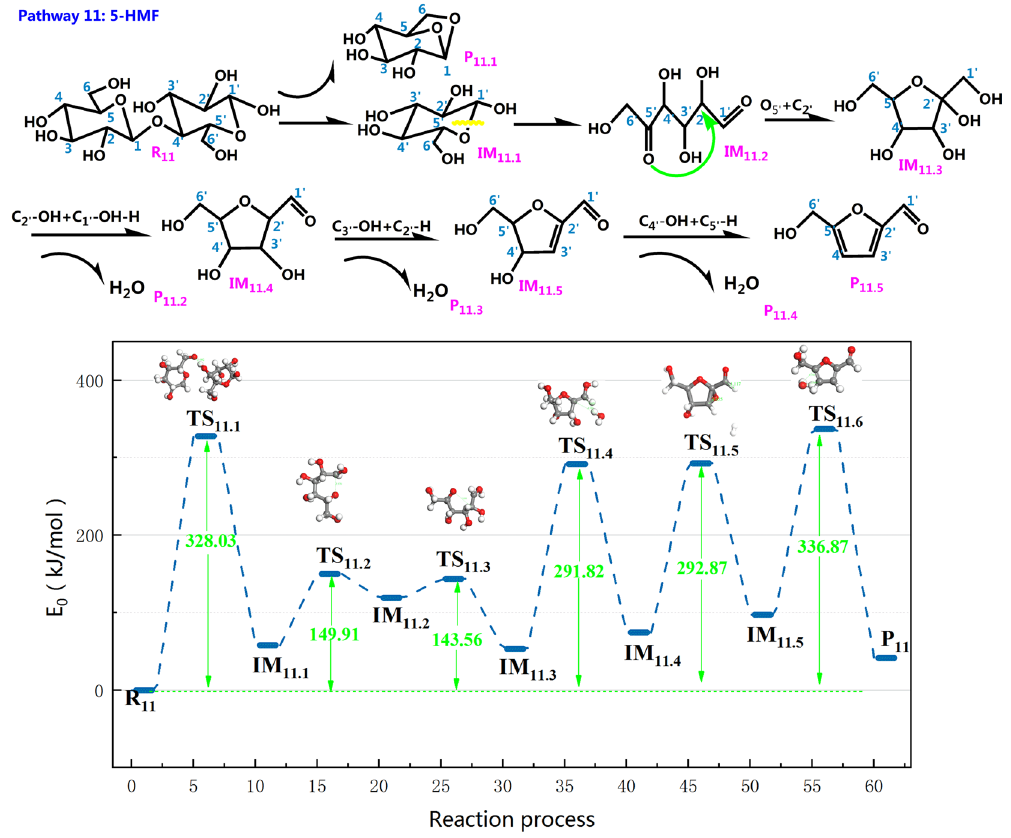
Figure 16. Reaction step and reaction energy barrier of pathway